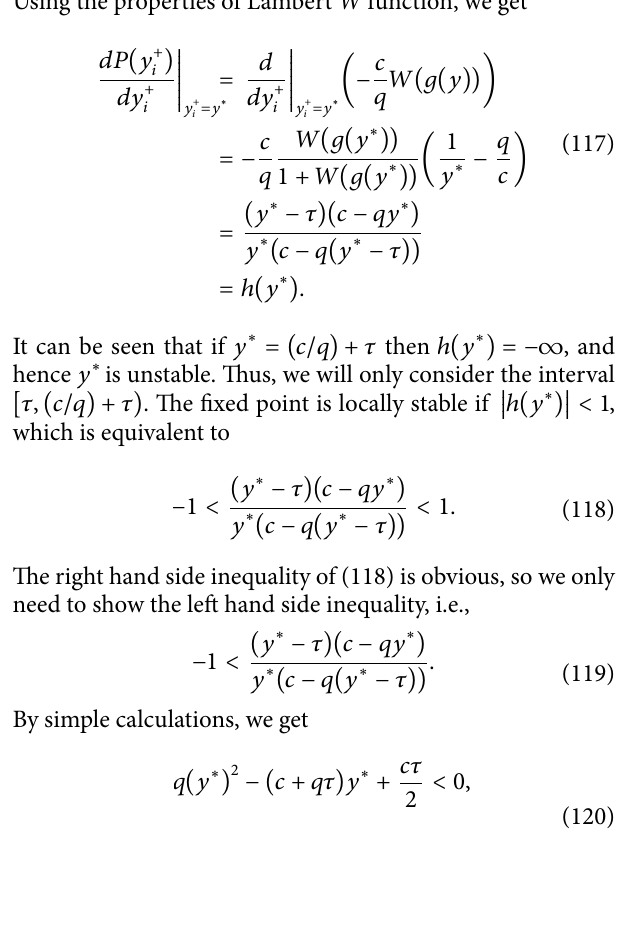
Figure 6: Effect of weighted parameters on the fixed point of Poincaré map for Case , and (f) . All other parametric values are fixed as: 훽 = 0.6 훽 = 0.9 퐴푇 = 6